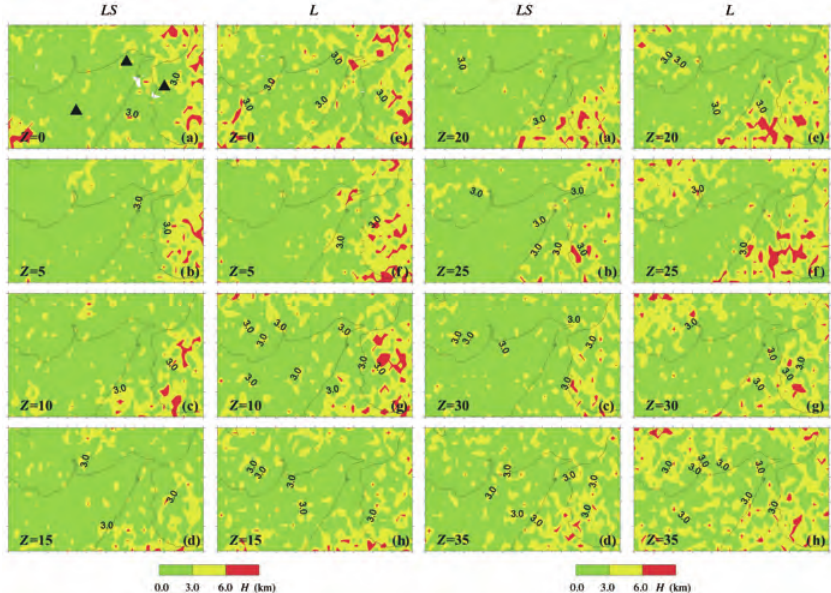
Fig. 8. Comparison of H -parameter horizontal distributions at different depths like in fig. 7 with the same stan- dard deviation (0.3